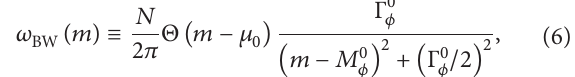
0 (timeismeasuredinlifetimes).